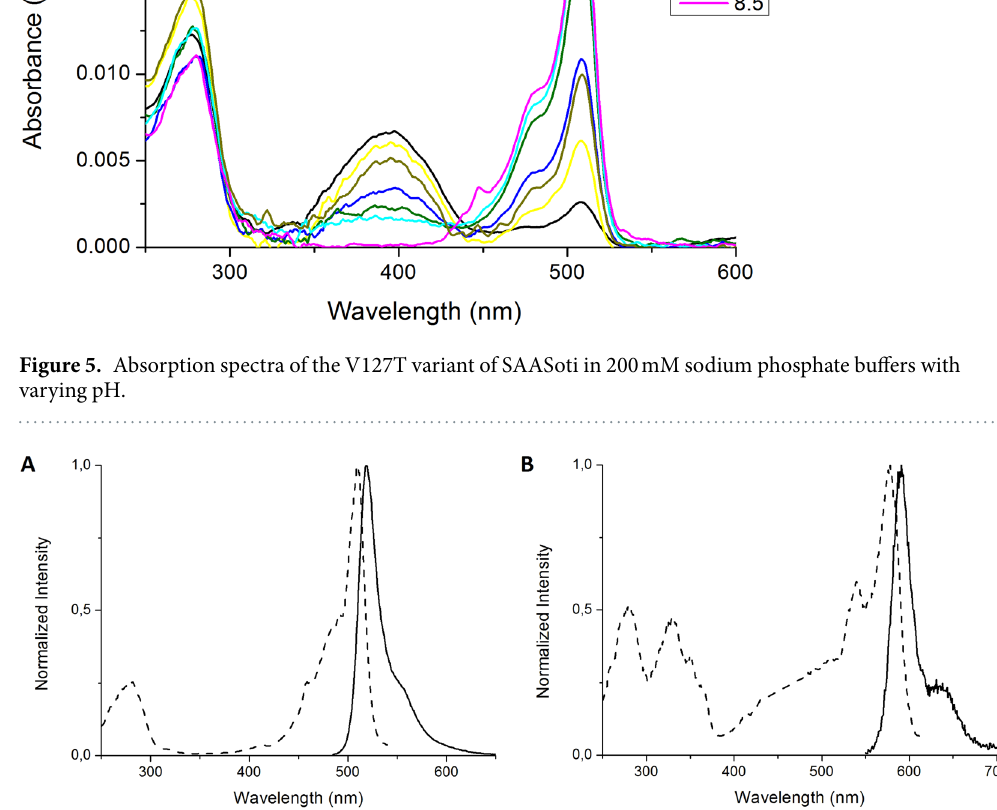
The green anionic form has an absorption and excitation maximum at 509 nm (Figs 5 and 6a), while the red form has a maximum of excitation at 579 nm (Fig. 6b). Only anionic form of both green and red chromophores is fluorescent. Correspondently, two pH equilibria that control by pK 1 and pK 2 and characterize chromophore anion to the neutral state transition were calculated from dependences of fluorescence intensities for green and red forms, respectively. As it can be seen from Table 4, modification of the hydrophobic interface with uncharged amino acid residues (V127T) does not result in a significant change of the pK 1 and pK 2 as compared to wt SAASoti, while substitutions in the charged interface increase the difference between the green and red forms. Comparing V127T SAASoti to Dendra2 shows more acidic pK values in the case of SAASoti, thus the fluorescent form of SAASoti will be preva- lent in the cytoplasm. Changes in the amino acid content of the surface and changes in the oligomerization cause a local pH change in the protein, thus altering the pK of the chromophore. Green-to-red photoconversion of SAASoti mutants in cuvette. The excitation and emission spectra of the green form of K145E suggested that the chromophore is in an anionic form (Fig. 6A), similar to mEos. Unlike mMaple and Dendra2, K145E does not show a noticeable presence of the neutral form of the chromo- phore within the 380–400 nm region and it shows only a very weak absorbance at 405 nm (Fig. 7A). Only the pro- tonated form ( λ abs = 385 nm, Figs 5 and 7A) can be irreversibly photoconverted into the red form. Nevertheless the photoconversion rate for K145E was much larger than that for Dendra2 (Fig. 7B). In order to study the impact of pH on SAASoti photoconversion, we induced photoconversion in its neutral state using 405 nm laser light with 30 mW intensity. As for the wild type SAASoti, all SAASoti mutants remained photoconvertible between their green and red fluorescent forms. The fluorescence maxima and shapes of both emission peaks for all mutants are nearly identical to those of the wild type protein. However, certain photochemical properties of the mutant proteins differ from those of the wild type (Table 4).